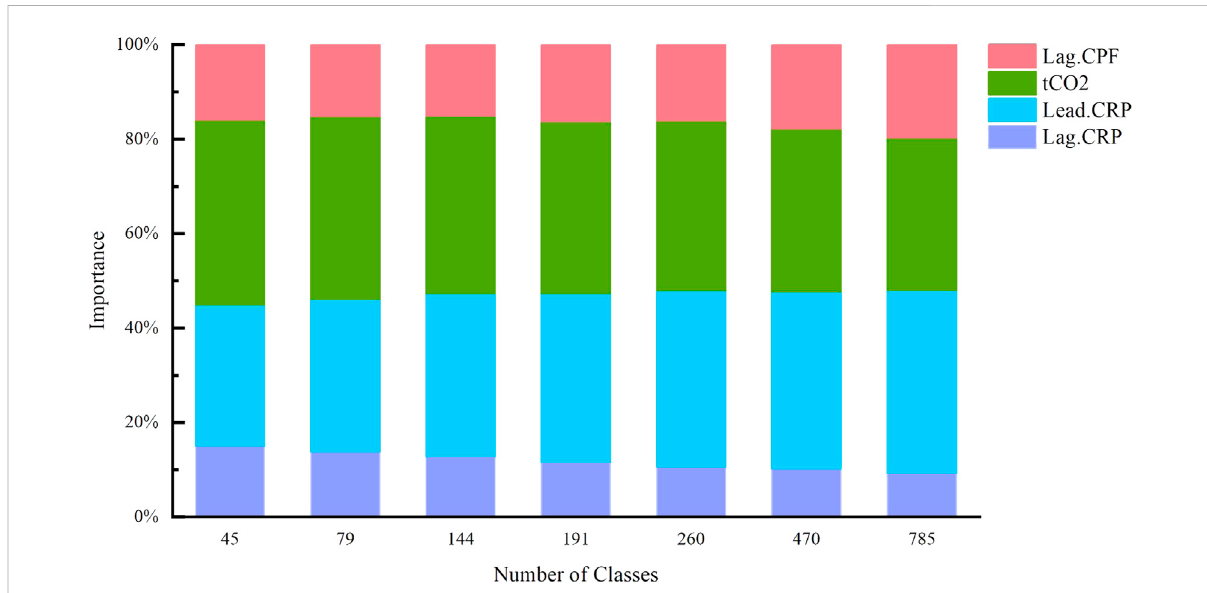
FIGURE 8 Importance of each variable to the energy consumption with different number of